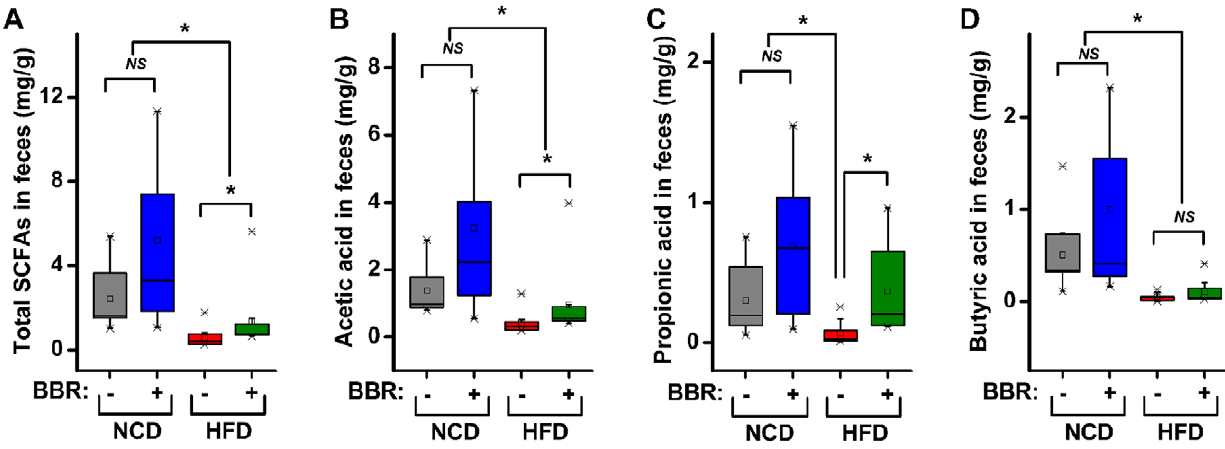
Figure 7. Fecal concentrations of SCFAs in rats. Levels of total SCFAs (A), acetic acid (B), propionic acid (C), and butyric acid (D) are shown. Total SCFA levels were calculated as the sum of acetic acid, propionic acid, butyric acid, n -valeric acid, isobutyric acid, and isovaleric acid. The median (central thick lines), 25% and 75% quartile ranges (box width), and upper and lower limits (error bar) of each group are shown in the box plot. Differences were assessed by the Mann-Whitney test, * P , 0.05; NS not